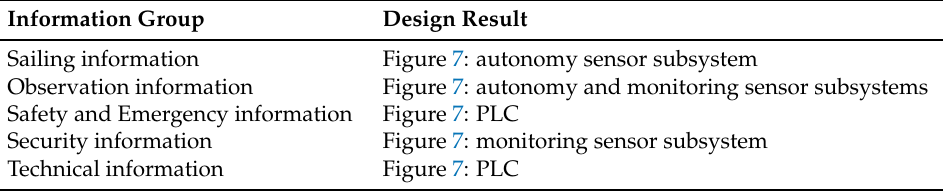
Table 2. Summary of information group realisations.